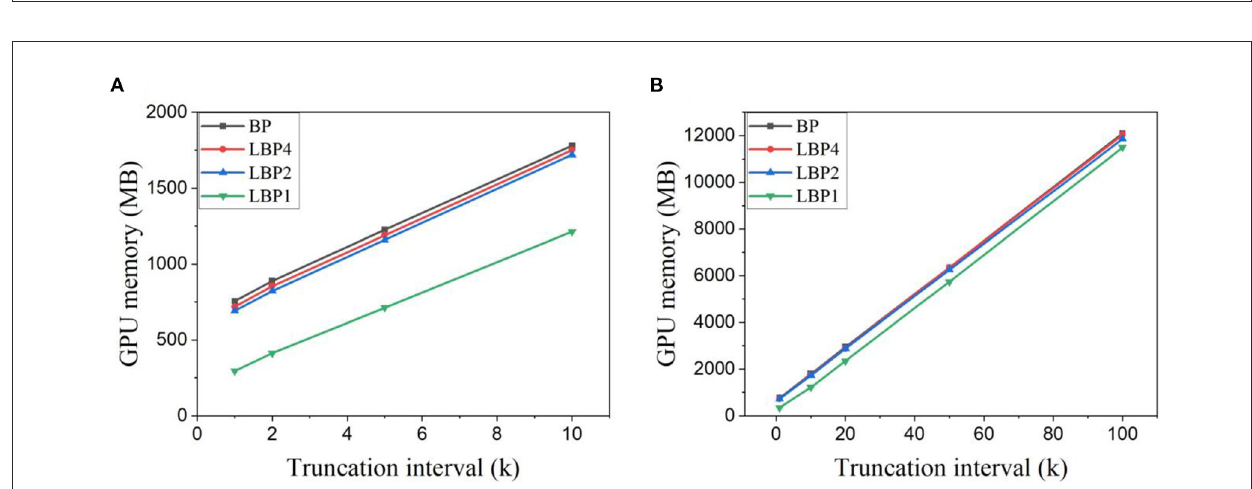
algorithm. Based on the backward update formulas in